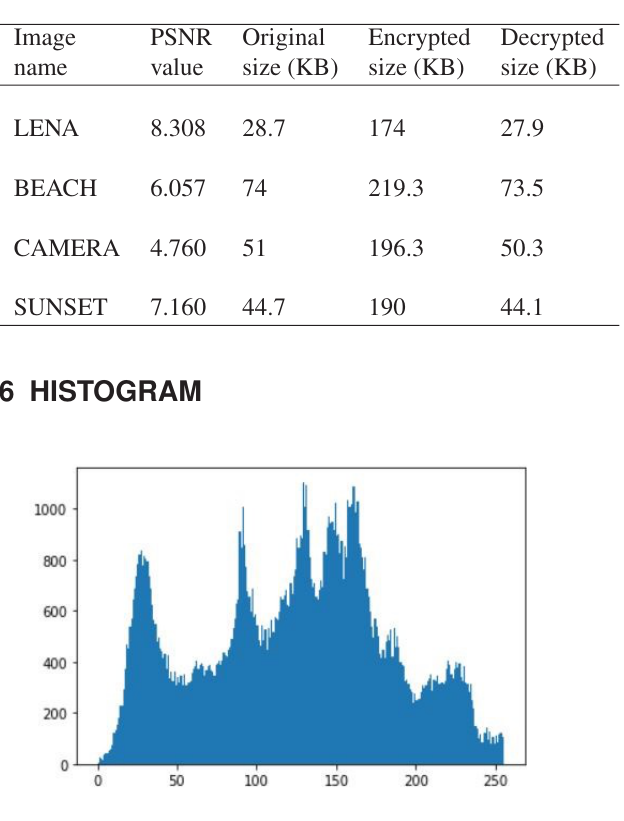
Figure 6. TEXT ENCRYPTION